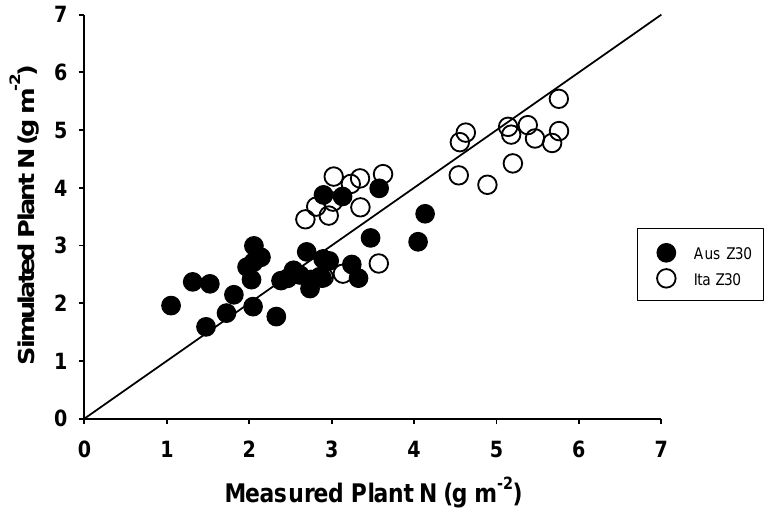
Figure 2. Canopy N (g∙N∙m −2 ) measured and predicted with the Canopy Chlorophyll Content Index (CCCI) for the Australian (full symbols) and Italian (open symbols) site at Z30 using the cross-validation method. The line represent the 1:1 relationship.